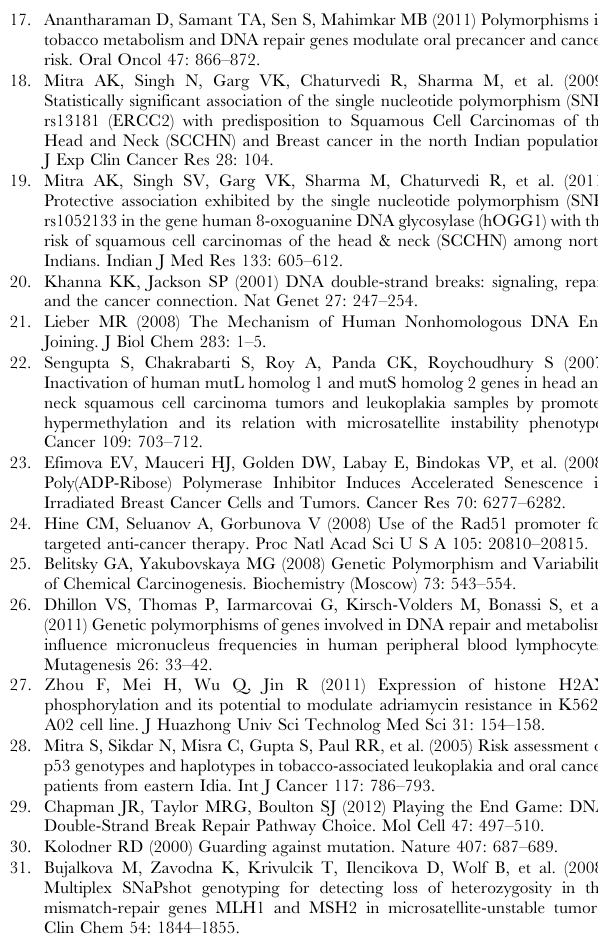
Figure S1 Population stratification analysis. Similar clustering was observed in principal component analysis (A) in case and controls, (B) in leukoplakia, controls and cancer and (C) in different geographical locations. Table S1 Genotypic association results among different comparison groups. Table S2 Estimated P Values of allelic association tests after adjustment of first four principal components. Table S3 Genotypic association results among different comparison groups with respect to tobacco exposure. Table S4 Genotypic results of replication study and comparison with discovery data.